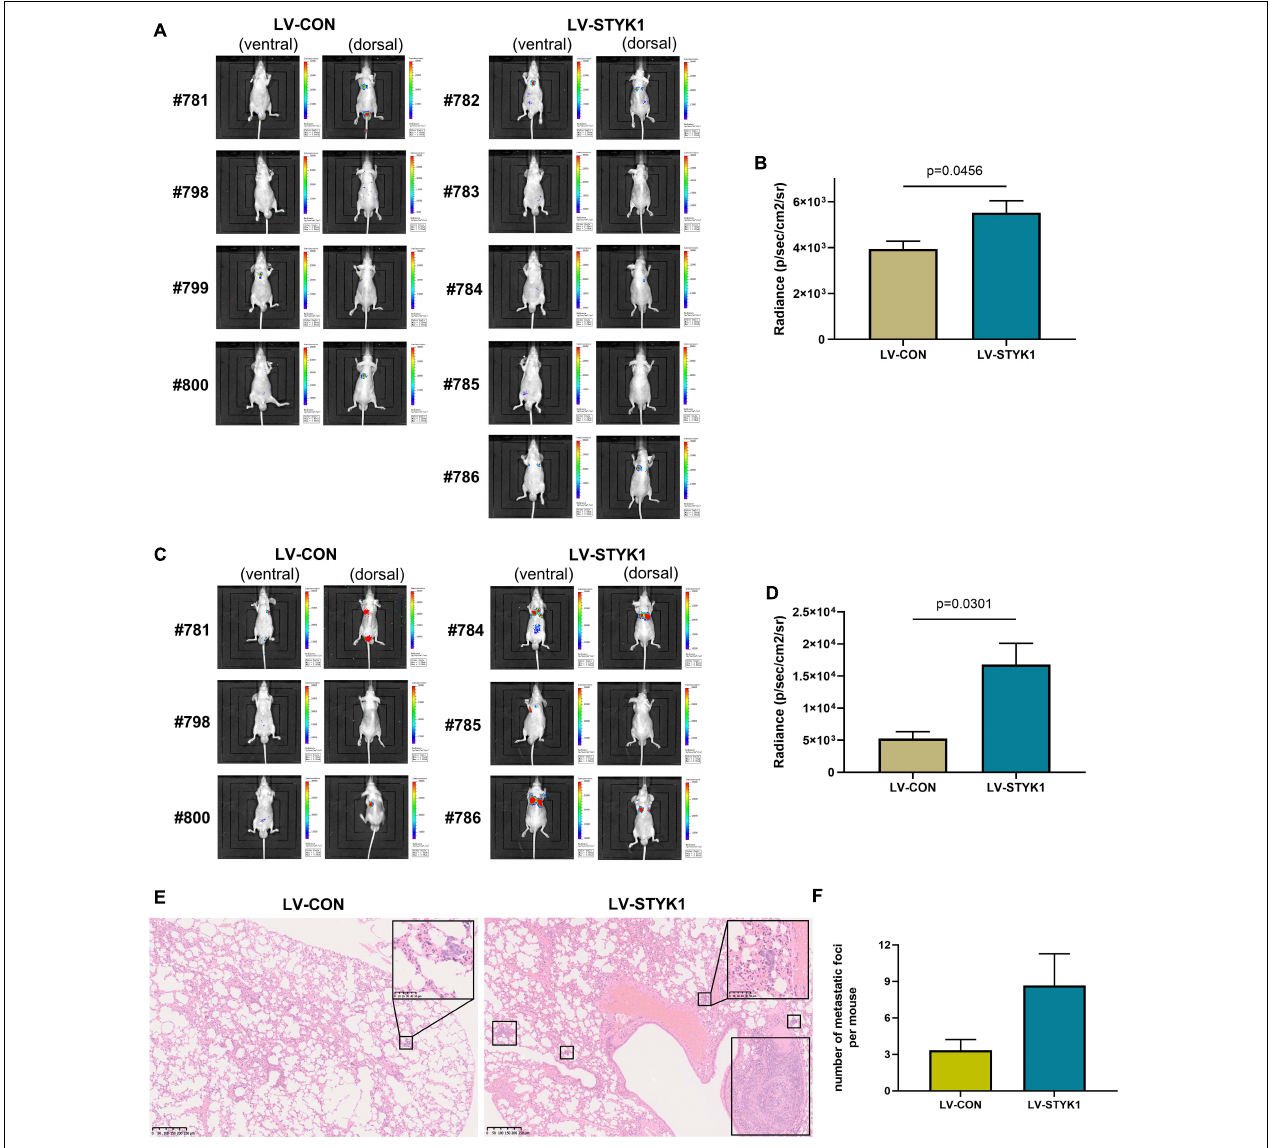
FIGURE 4 | Overexpression of STYK1 promotes metastasis of SW900 cells in nude mice. (A) Luminescent images of nude mice in 4 weeks after tail vein injection of SW900 cells. (B) Quantitative analysis of radiance in 4 weeks after tail vein injection of SW900 cells; P = 0.0456, Student’s t -test. (C,D) Luminescent images of nude mice and quantification of radiance in 5 weeks after tail vein injection of SW900 cells; P = 0.0301, Student’s t -test. (E) Representative histological sections of lung metastatic lesions. (F) Comparison of the number of lung metastasis between groups (three mice per group); P = 0.1243, Student’s t -test. LV-CON, mice injected with control SW900 cells; LV-STYK1, mice injected with SW900 cells STYK1